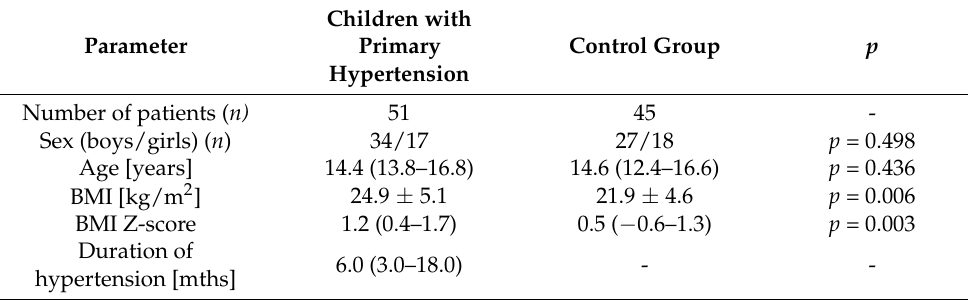
Table 1. Clinical characteristics of the examined population.